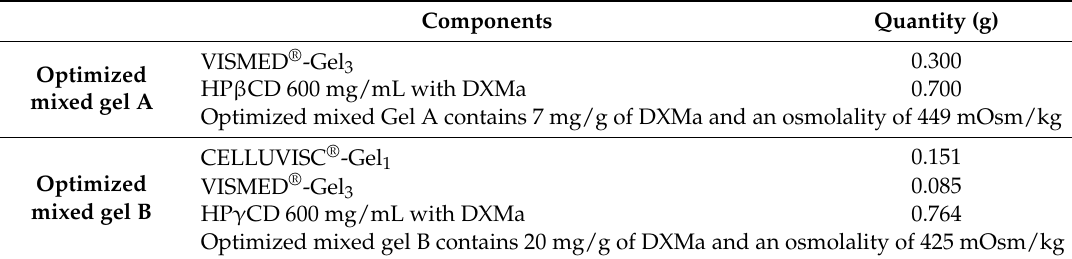
Table 8. Composition of optimized mixed gels A and B.